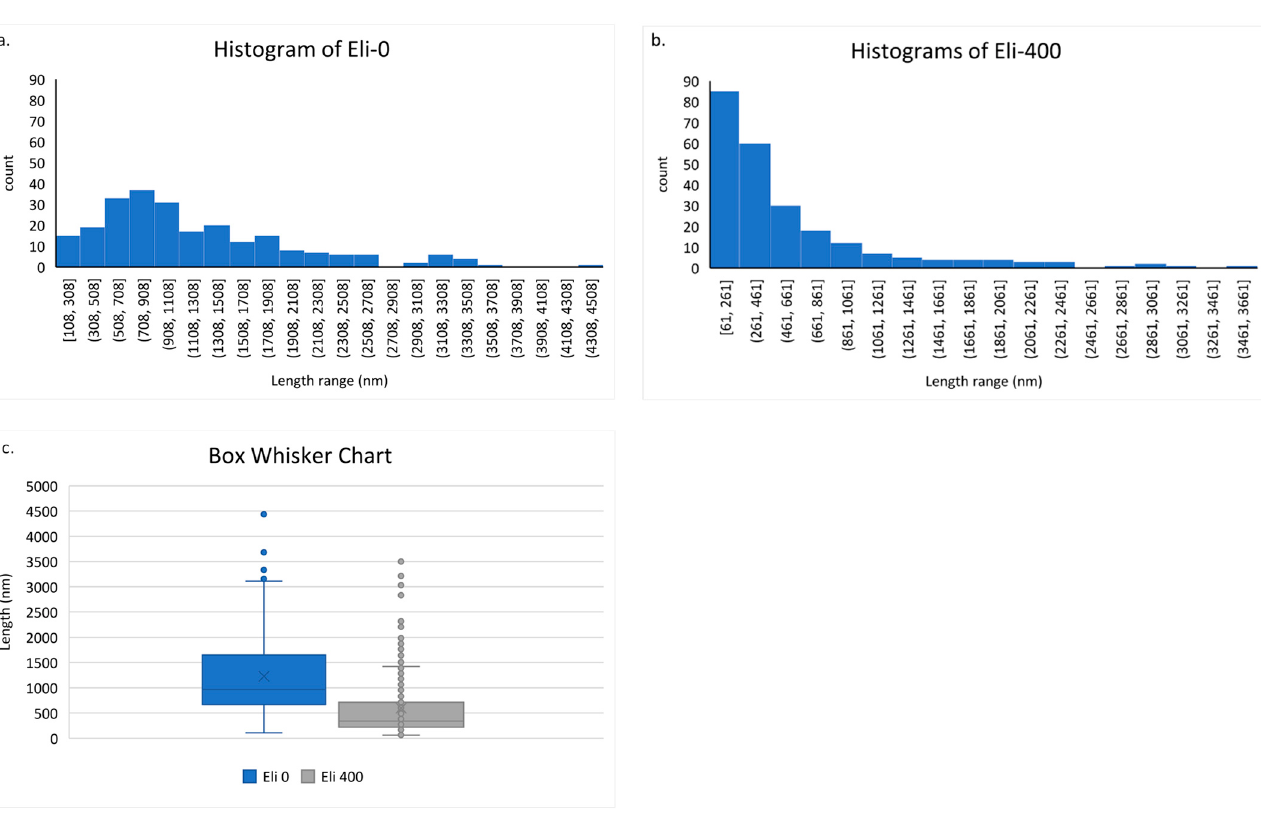
Figure 5. ( a ) Histogram of length distribution of Eli-0 CNTs, ( b ) histogram of length distribution of Eli-400 CNTs, and ( c ) Box Whisker chart of Eli-0 and Eli-400 CNTs.